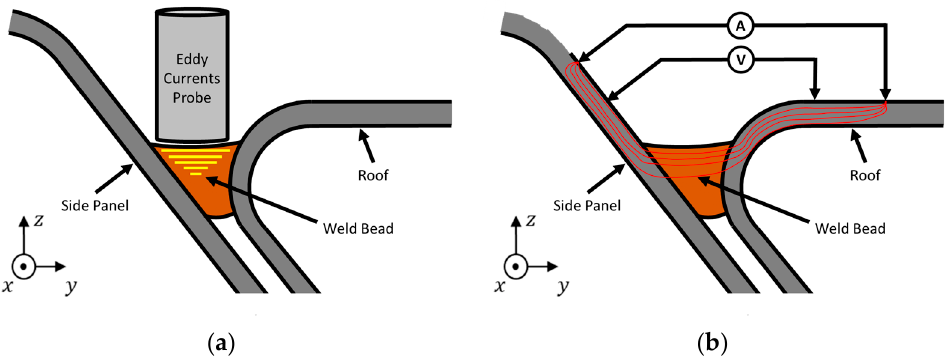
Figure 2. Inspection methods envisaged. ( a ) Eddy currents testing ( b ) potential drop measure- ment.